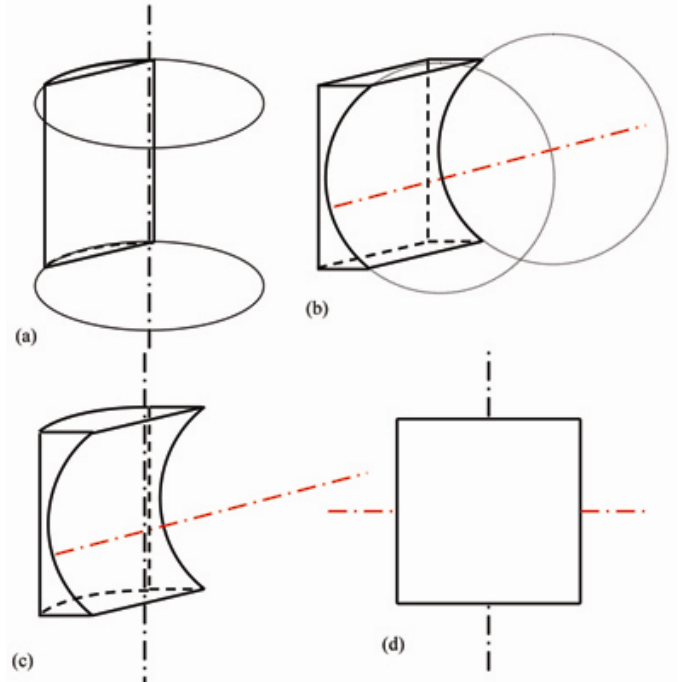
Figure 3 Schematic representation of the bicylindrical lens optically equivalent to the lens in Figures 1 and 2. The lens is imagined made up of a front portion (a) and a back portion (b) fused to make the lens in (c) and shown in front view in (d). Its form is { } { } 0.5 180 0 0.5 90 0 − . The axis of the back cylinder is shown in red; the axis of the front cylinder is shown in black. Notice that both axes lie behind the lens as shown in (d). The curvatures are greatly exaggerated; as a result the axes are shown much closer to the lens in (c) than they actually are, their true positions being just over 1 m behind the lens.